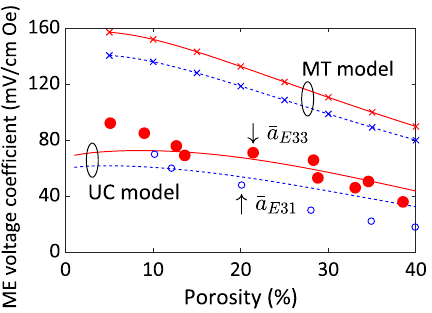
Figure 2. Comparison of micromechanical predictions and experimental measurements on the effective ME κ ε , H 33 (red solid lines and dots) and transverse coefficient voltage coefficients: longitudinal coefficient a E 33 = a ε 33 = a ε a E κ ε , H 33 (blue dashed lines and circles) for a fully constrained 60% nickel ferrite/40% PZT composite as (cid:31) 31 11 a function of the percentage of porosity. The experimental data is obtained from Petrov et al. 43 . ME, MT and UC (cid:31) are abbreviations for magnetoelectric, Mori–Tanaka and unit-cell, respectively.